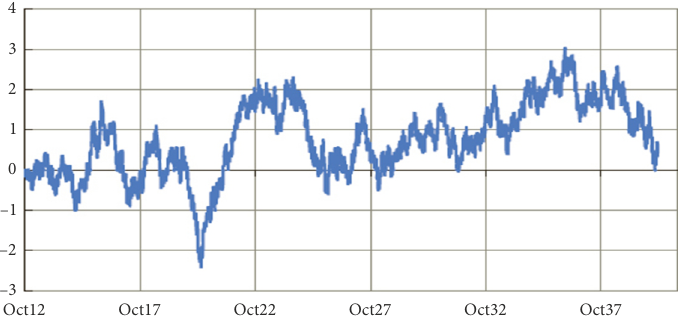
Figure 2. Mean reversion process (source: Huggins and Schaller